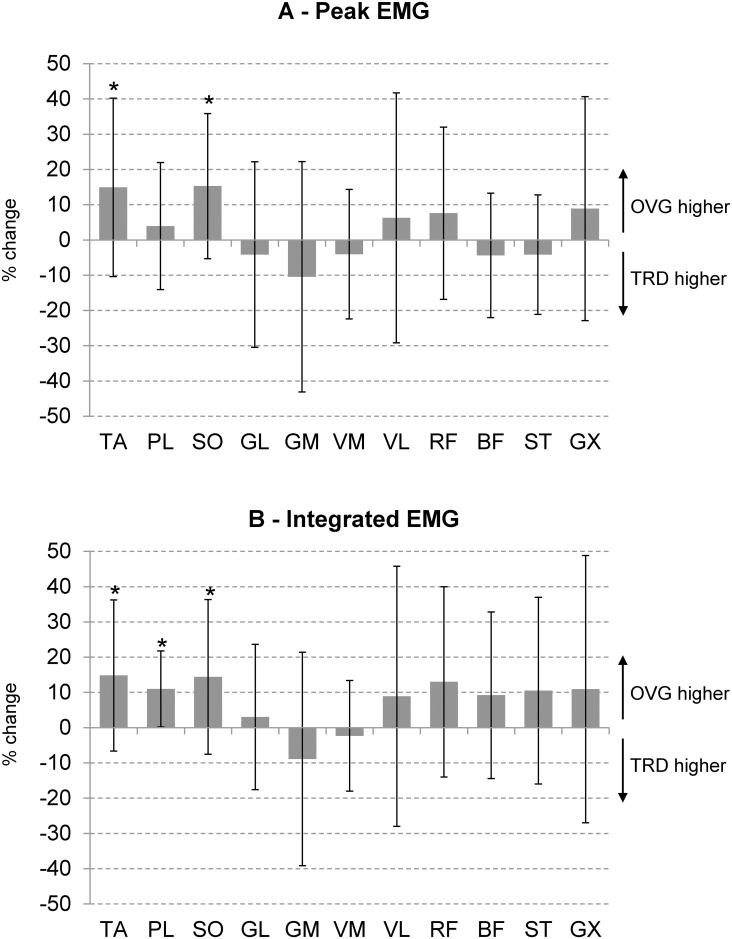
EMG Comparison of treadmill vs overground.Percentage of change between treadmill (TRD) and overground (OVG) running for the peak EMG (A) and integrated EMG (B) throughout a gait cycle. Data from OVG running were normalized by the values from TRD running. * denotes significant differences between treadmill and overground running (p<0.05).